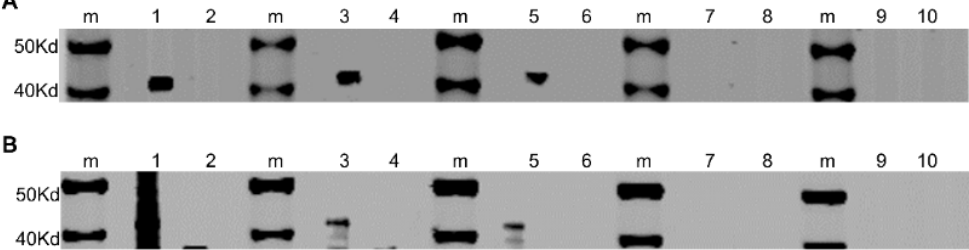
Figure 6. Determination of the optimum dilution of the test sera for western blot immunoassay.